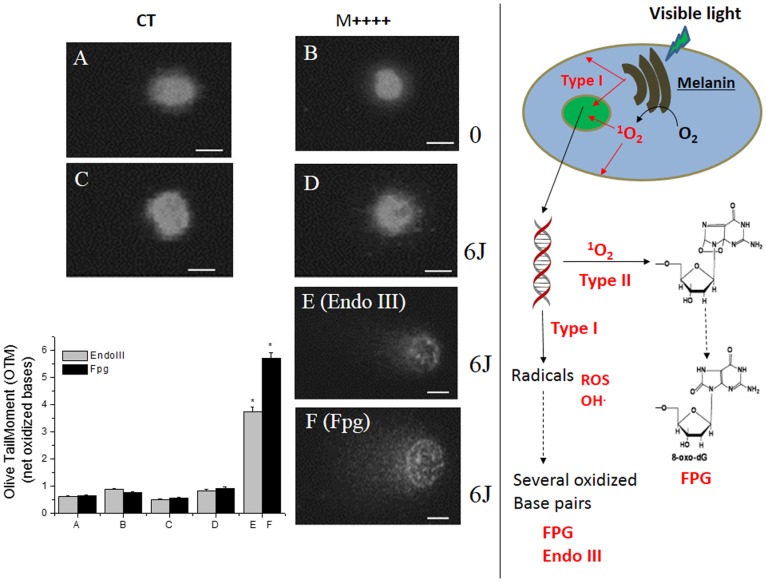
Melanin photosensitization with visible light damages nuclear DNA.(Left) Comet assay. (A) B16-F10 CT cells in the dark after treatment with 0.2 U of Fpg (treatment with Endo III yielded the same results); (B) B16-F10 M++++ cells in the dark after treatment with 0.2 U of Fpg (treatment with Endo III yielded the same results); (C) B16-F10 CT cells exposed to 6 J.cm−2 of visible irradiation after treatment with 0.2 U of Fpg (treatment with Endo III yielded the same results); (D) B16-F10 M++++ cells exposed to 6 J.cm−2 of visible irradiation without enzymes; (E, F) the same as D treated with 0.2 U of Endo III (E) and Fpg (F). The graphic on the left shows the quantification of the DNA fragmentation in B16-F10 cells under conditions A through E. (Right) A schematic of melanin photosensitization via type I and type II mechanisms, leading to damage in several biological targets, including the cell membrane and nuclear DNA. The DNA changes are indicated by using the main Fpg and Endo III recognition sites.